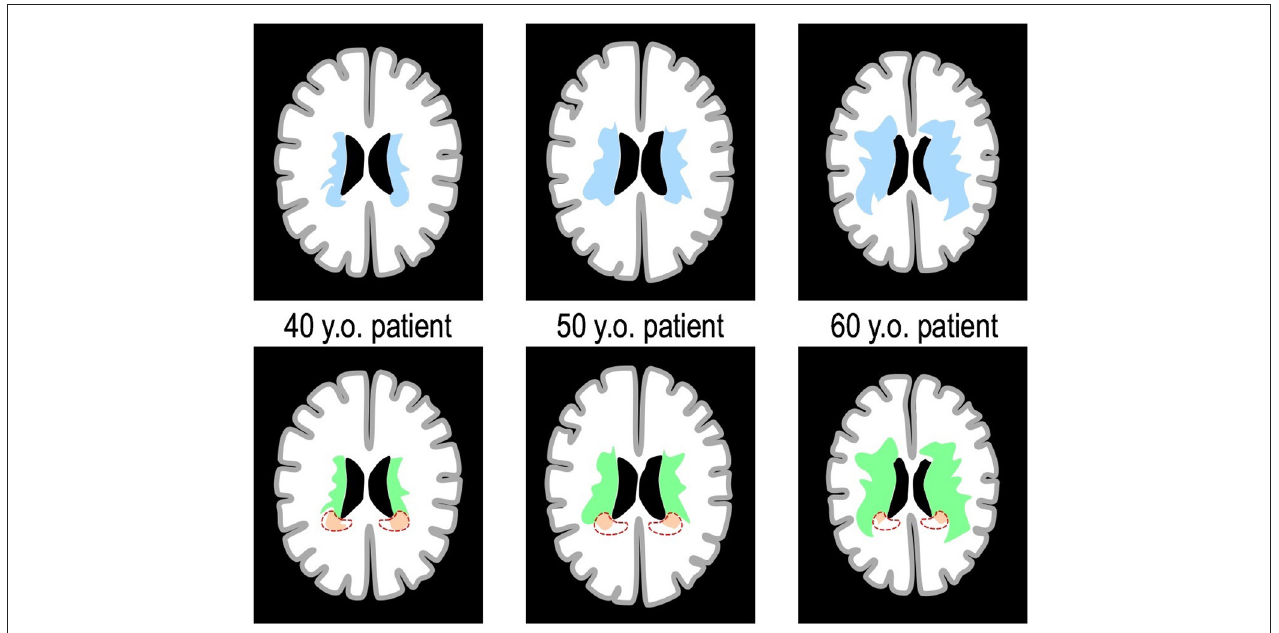
FIGURE 1 | Spatial burden of WMH and the hypothesis of different populations. The schematic represents 3 theoretical patients of increasing age, with on the ( Top Line ) the masks of the whole burden of WMH overlaid on the same axial brain slice (in blue). We hypothesized that the whole burden of WMH results from the combination of different populations of WMH that appear predominantly in certain areas. For instance, the red area on the ( Bottom Line ) represents a theoretical region in which WMH (in orange) would have a specific mechanism inversely related to age. In this case, while the extent of WMH in the red area is inversely related to age, the study of the whole extent of WMH (in blue on the Top Line ) would not detect this aspect. By contrast, the unsupervised study of the sources of variation of the whole pattern of WMH, used in the present study, would likely detect